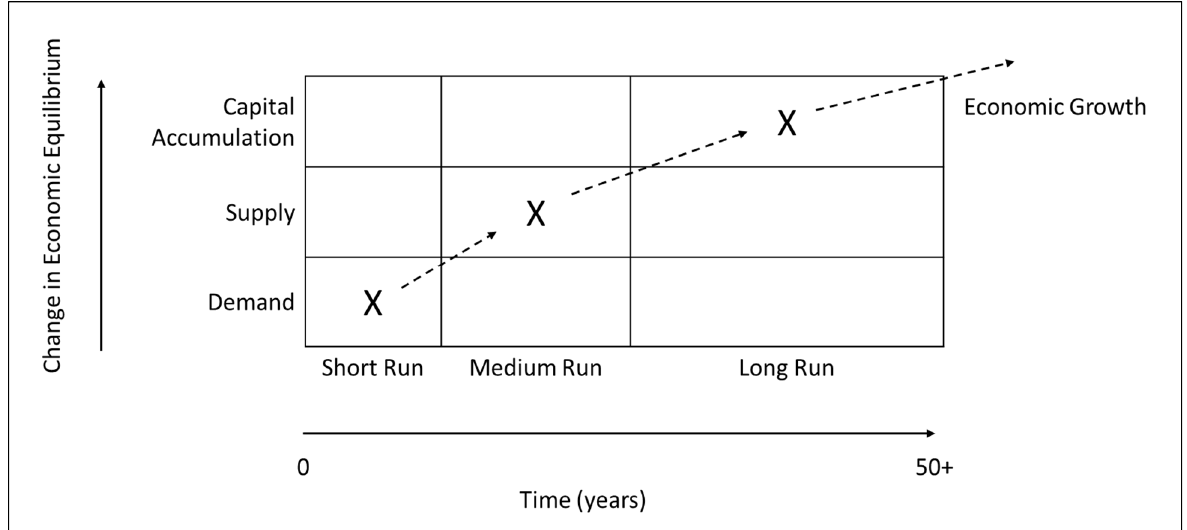
Figure 1. Simplified Timeline of Economic